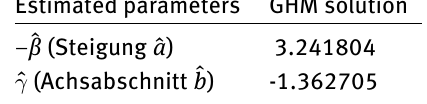
Table 4: TLS solution - line fit